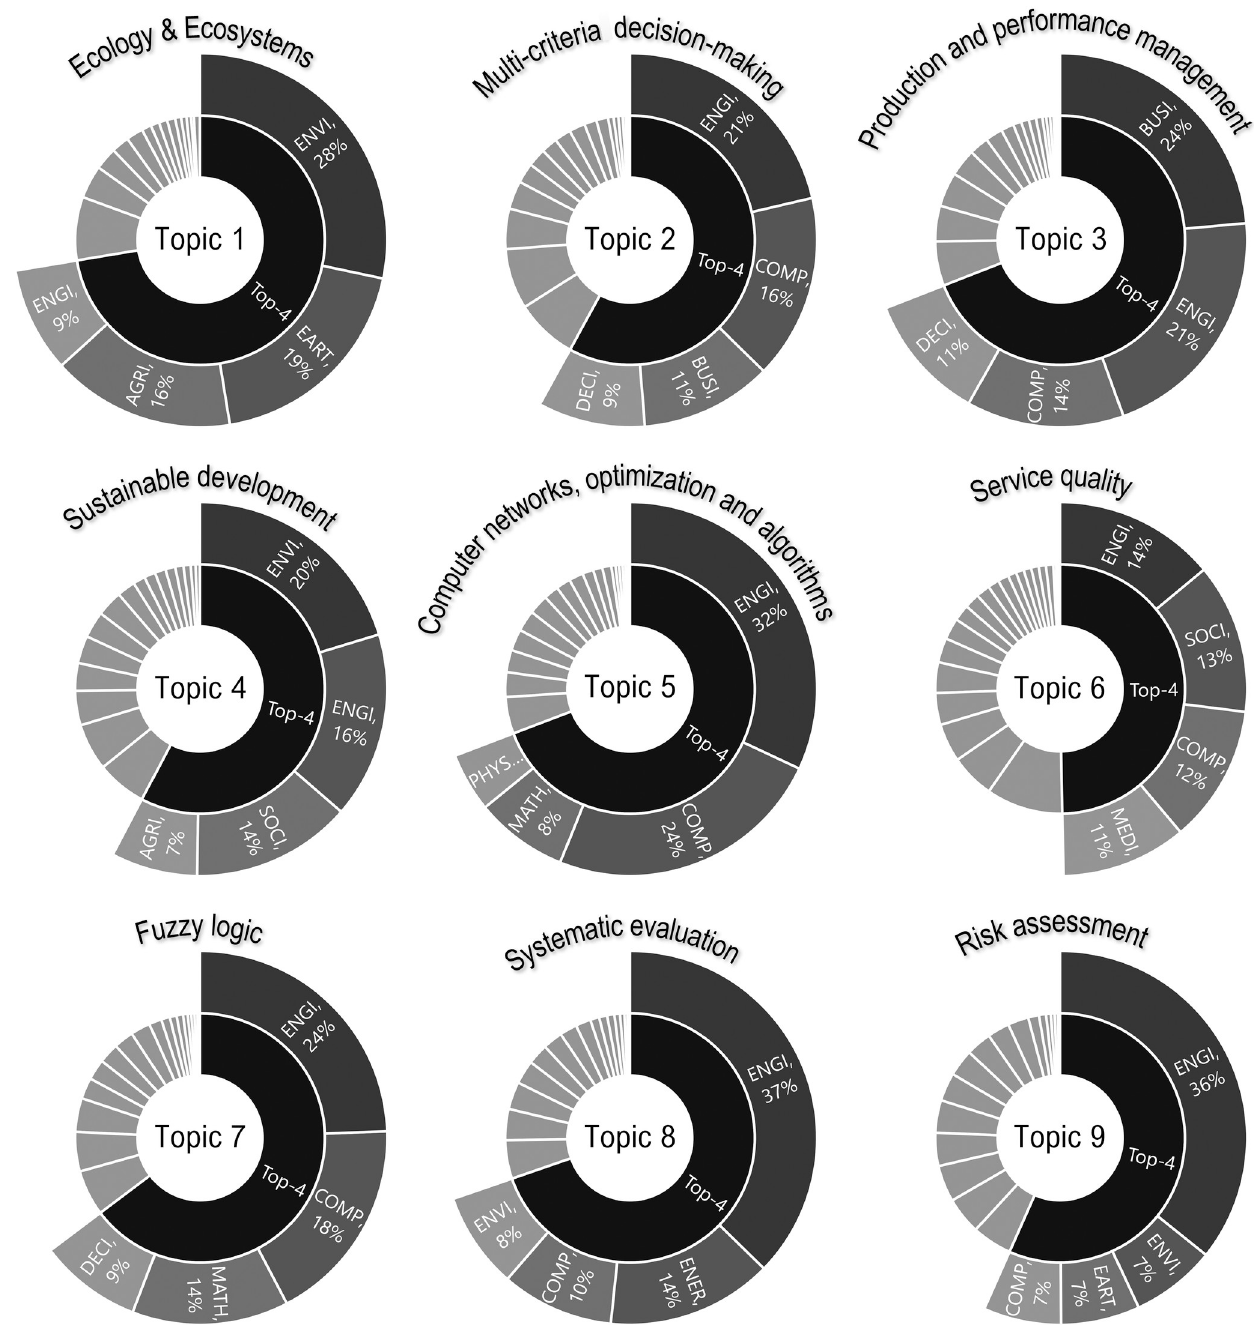
Fig 7. Names of topics and their composition of subject